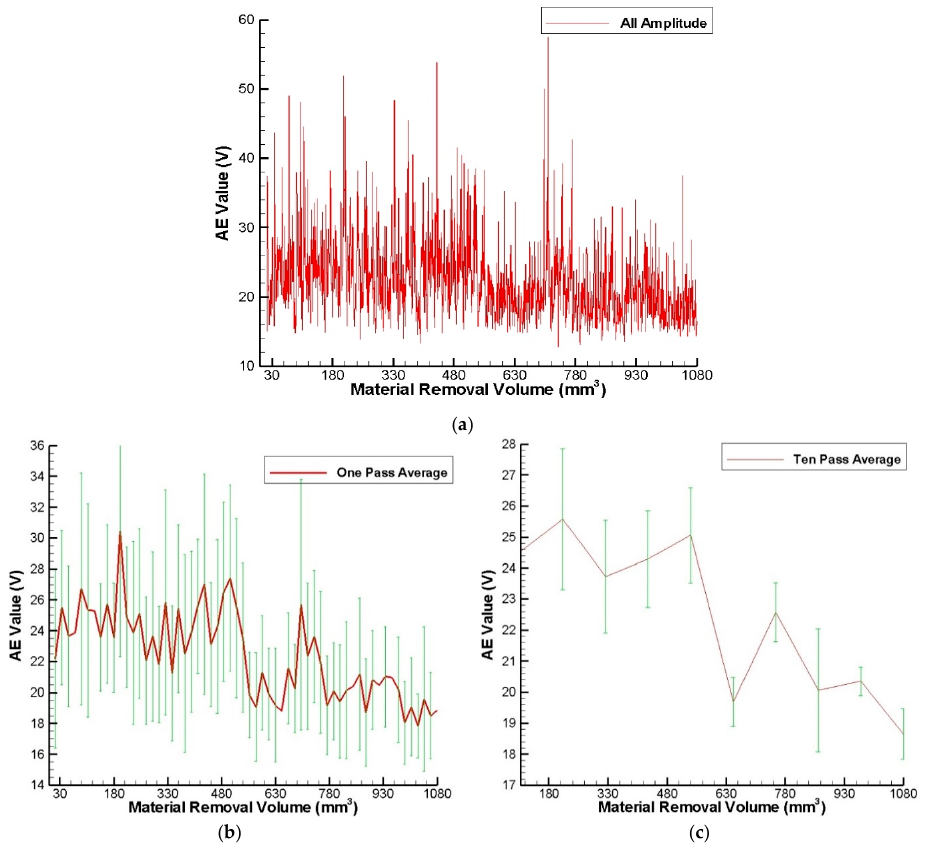
Figure 5. Measured AE signals under 100 repeated experiments ( a ) original data, ( b ) take an average of one experiment, and ( c ) take an average of ten